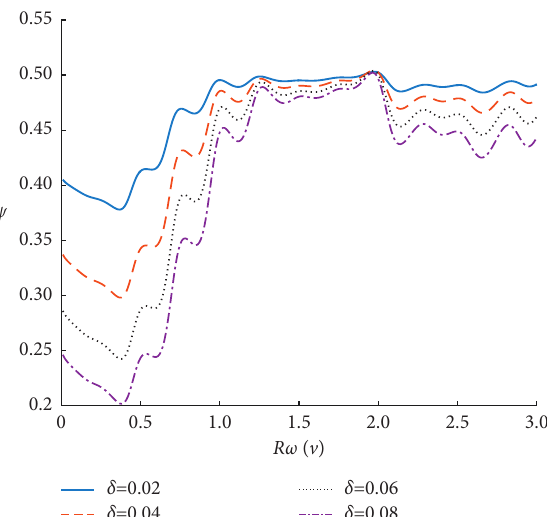
Figure 8: Curves of radial stress varying with frequency for dif- ferent shear modulus ratio of affected region.